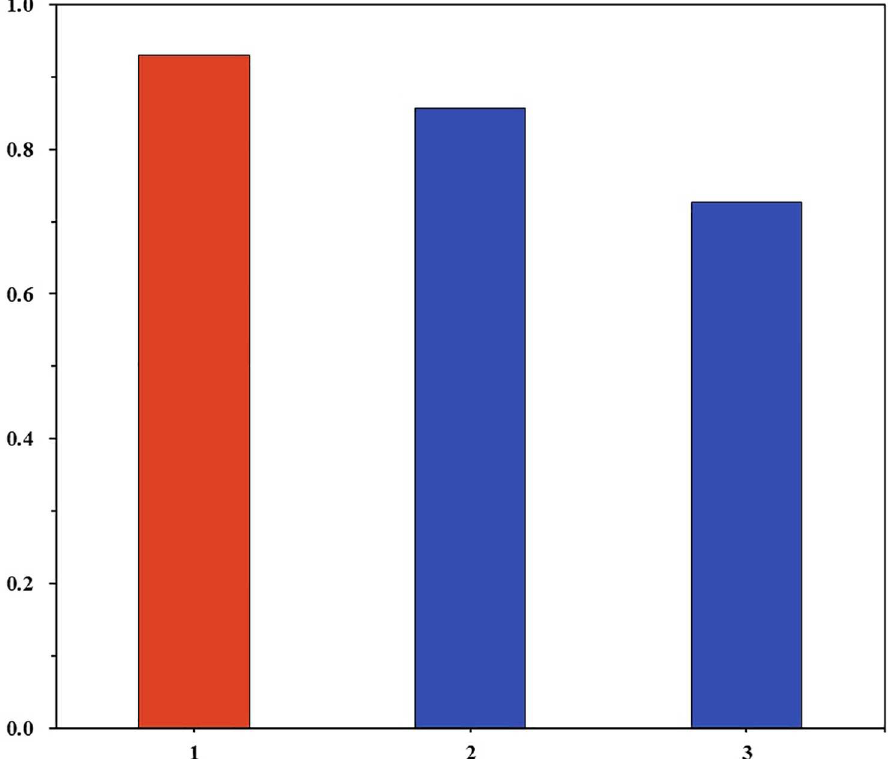
Fig 10. Prospect for impeachment and social networks. 1. Support for impeachment(Gallup Korea Poll on December 9, 2016; aged from 19 to 29) 2. High prospects for impeachment(Middle+High density group) ( N = 35) 3. High prospects for impeachment (Low density group) ( N =